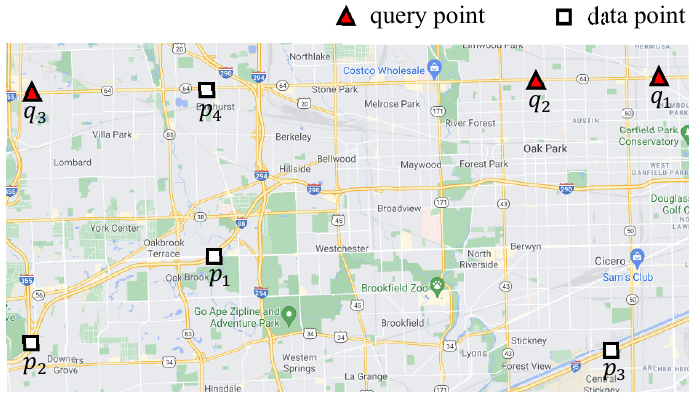
Figure 1. Example of k FN join Q (cid:110) kFN P , where Q = { q 1 , q 2 , q 3 } and P = { p 1 , p 2 , p 3 , p 4 }